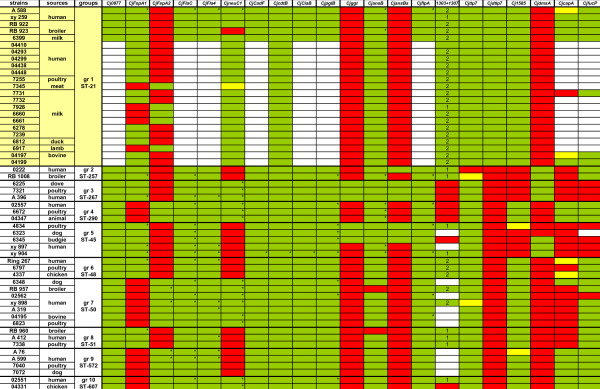
Pathotyping scheme of 55 C. jejuni strains ordered according to STs. Each of ten groups represents one ST and contains at least one strain from human, one strain from animal and one strain from food sources. The distribution of putative virulence- and host-associated genes was tested by PCR (primer combinations in Table 2). The presence of genes Cj1305 and Cj1306 was detected using a combination of primers in Cj1303 and Cj1307, by PCR product length: 1 indicates the presence of just one gene, either Cj1305 or Cj1306, and 2 indicates the presence of both genes. Color-coding: green: gene present; red: gene not present; yellow: weak PCR product; white: not tested. Gene copies marked by asterisks were additionally sequenced to identify interstrain polymorphisms using Sanger sequencing.